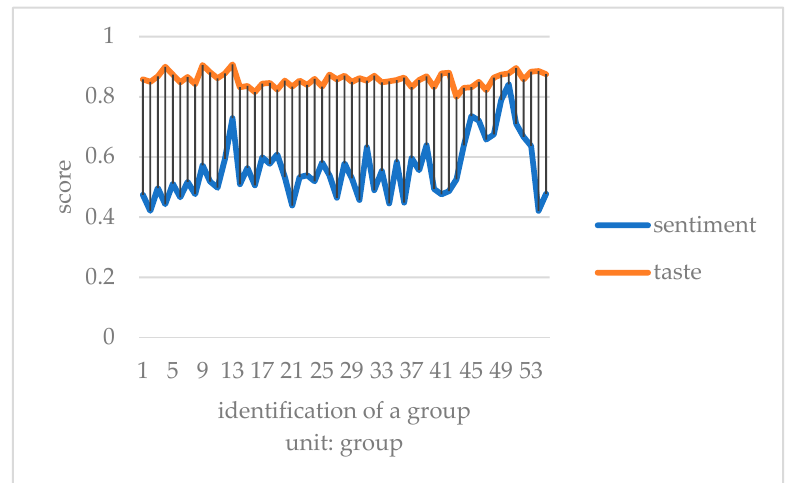
Figure 10. Chart of emotional score and dish taste after COVID-19.